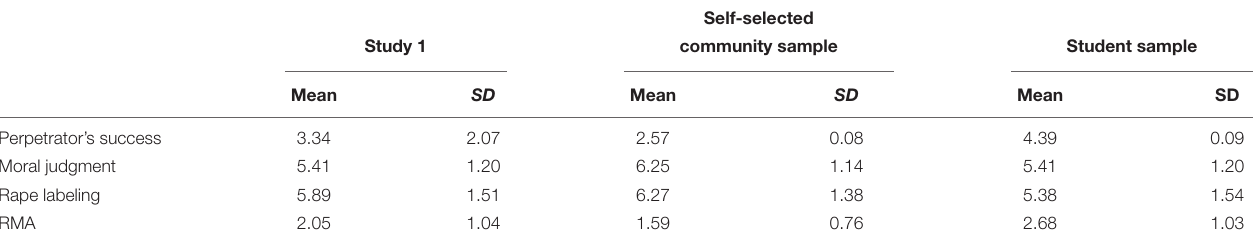
TABLE 1 | Descriptive statistics of Study 1.